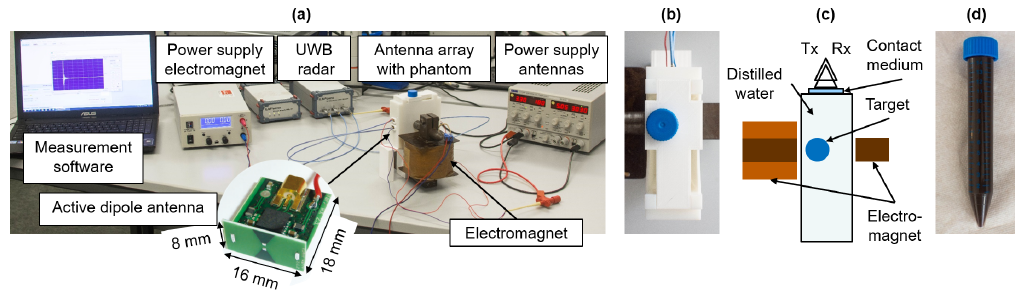
Figure 2. Experimental measurement setup: ( a ) A 3D-printed tank filled with distilled water is placed inside the air gap of the electromagnet. This tank acts as an antenna array. The active dipole antennas are connected to an UWB M-sequence radar. ( b ) Top view of the phantom inside the air gap of the electromagnet with a mount holding the test glass in the right position. ( c ) Corresponding schematic of the phantom box inside the air gap. ( d ) One of the test tubes filled with MNPs embedded in